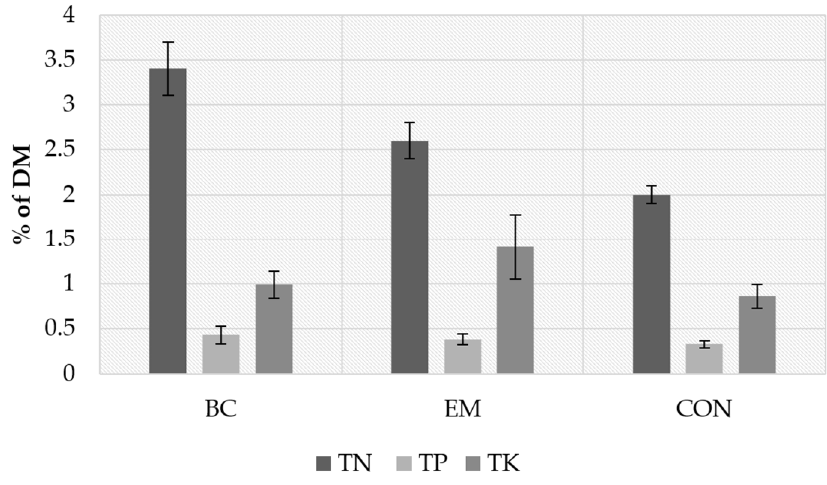
Figure 3. Mean nutrient content in final composts. TN—total nitrogen, TP—total phosphorus, TK—total potassium with standard deviation in error bars.